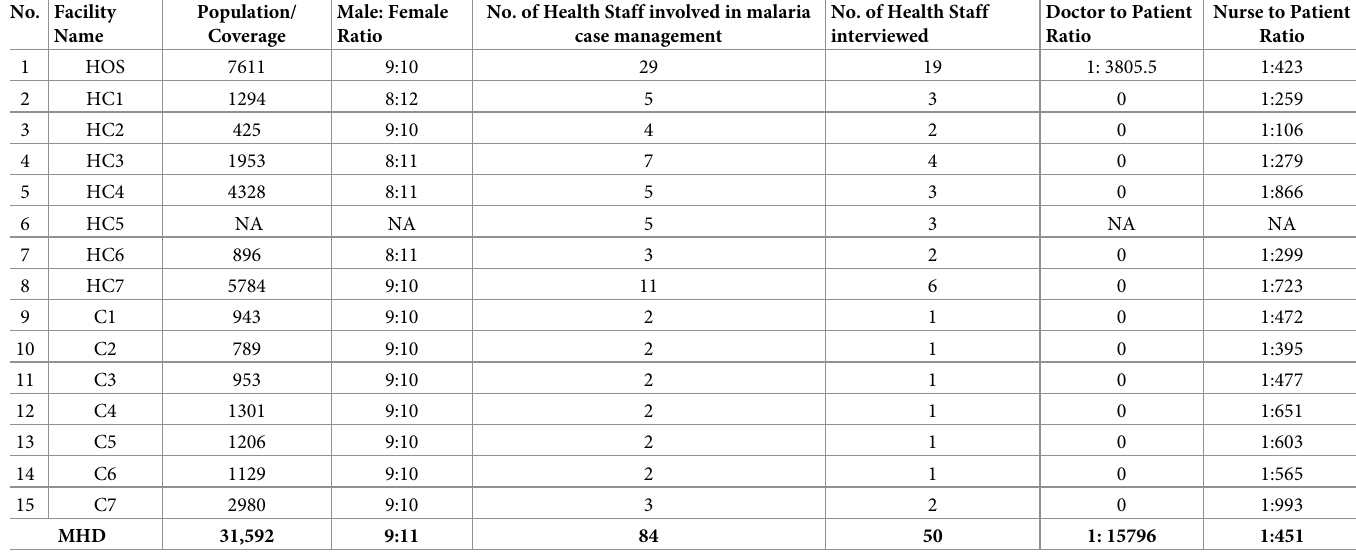
Table 1. Characteristics of the facilities included in the